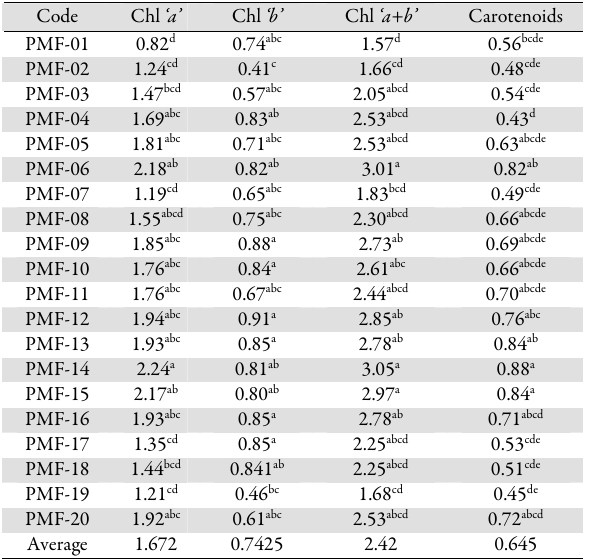
Tab. 2. The chlorophyll (photosynthetic) pigment content in local bean populations Code